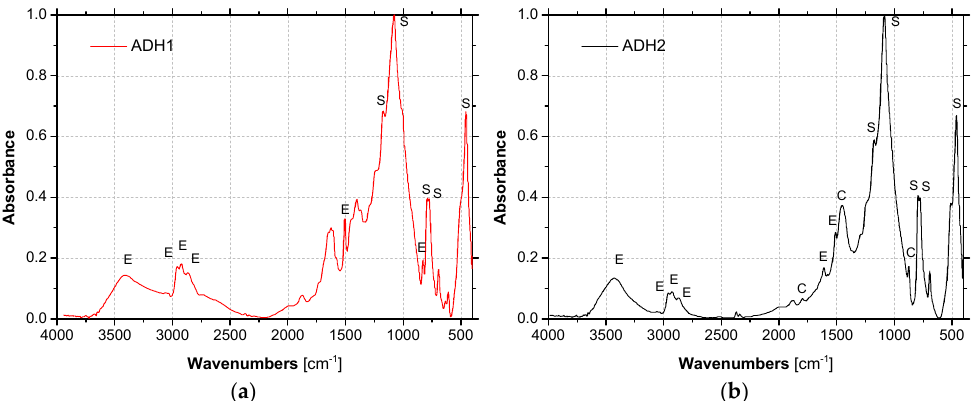
Figure 7. FTIR spectra of unaged adhesives ( a ) ADH1 and ( b ) ADH2 - assignment of IR peaks: E-epoxy, S-silicates and C-carbonates.